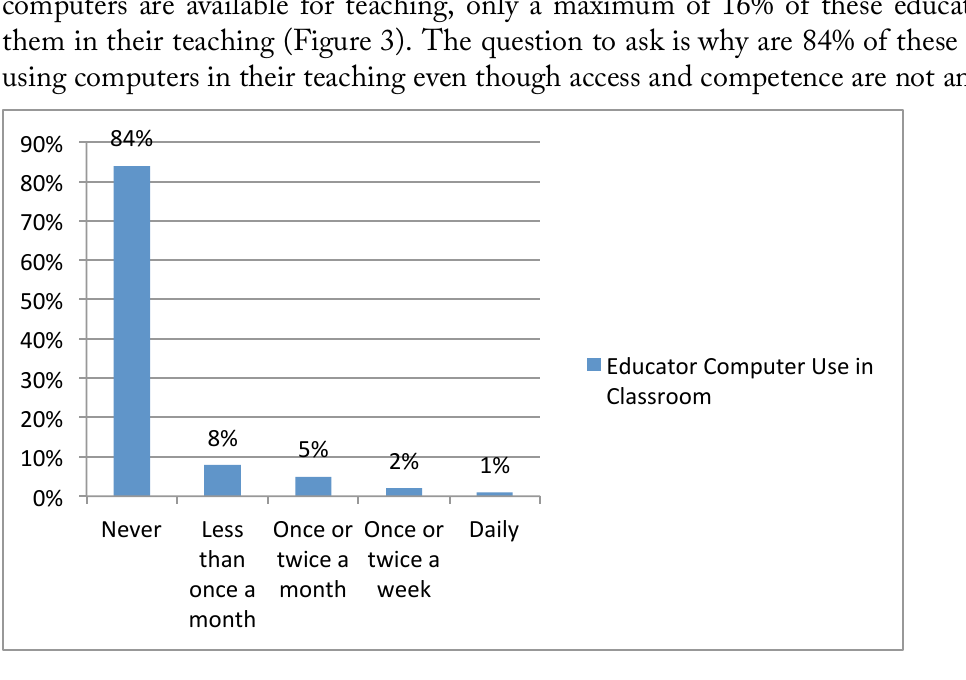
Figure 3: Educator computer use in